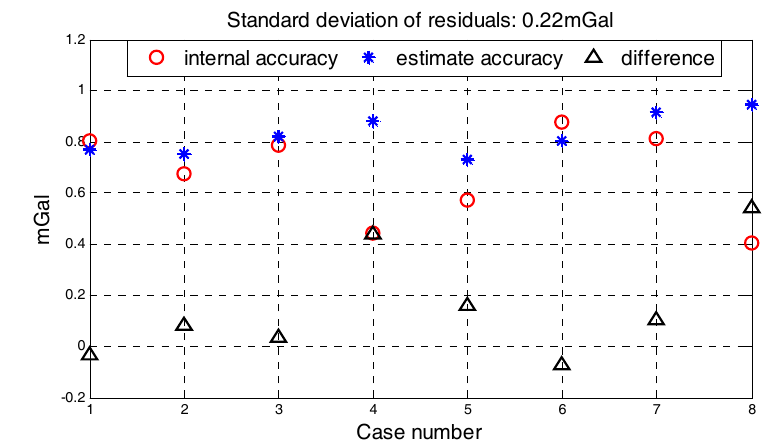
Figure 13. Differences between the quality assessment results and internal RMSE. Table 6. Characters of Neimeng